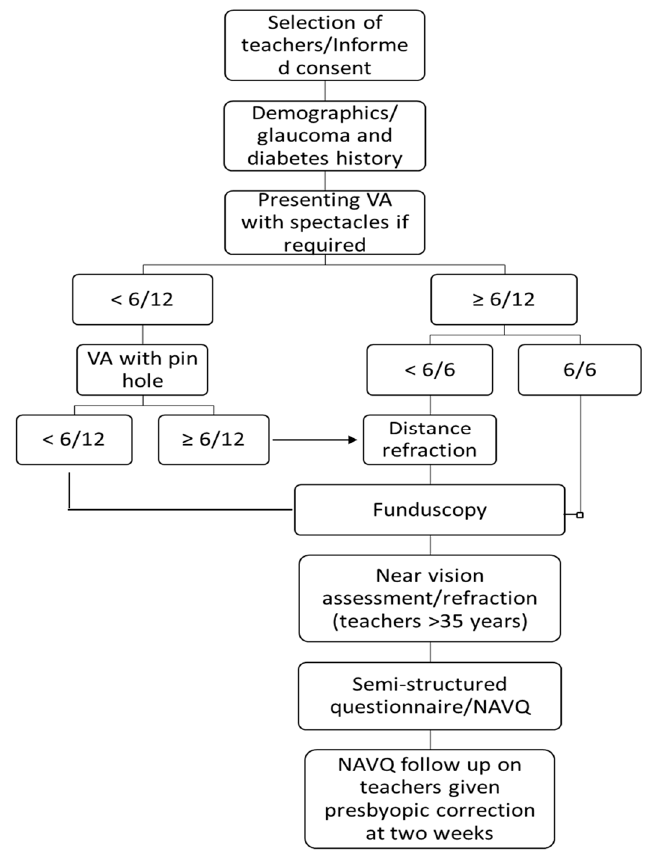
Figure 1. Examination flow chart.